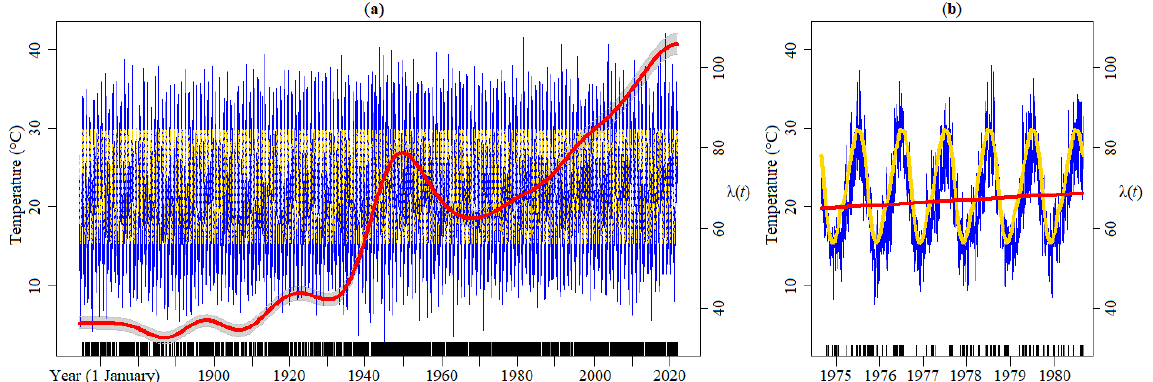
Figure 7. Time dependent occurrence rates from 1 October 1864 to 30 September 2021 of Tmax heatwave days: ( a ) daily Tmax (in blue), heatwave magnitude index threshold series, A d (in gold), number of heatwave days per year, λ ( t ) (red line), and confidence band (grey area); ( b ) detail for the 7-year period from 1975 to 1980 (the confidence band is omitted). The vertical ticks represent the time data of ≥ 3 consecutive days with Tmax above A d .